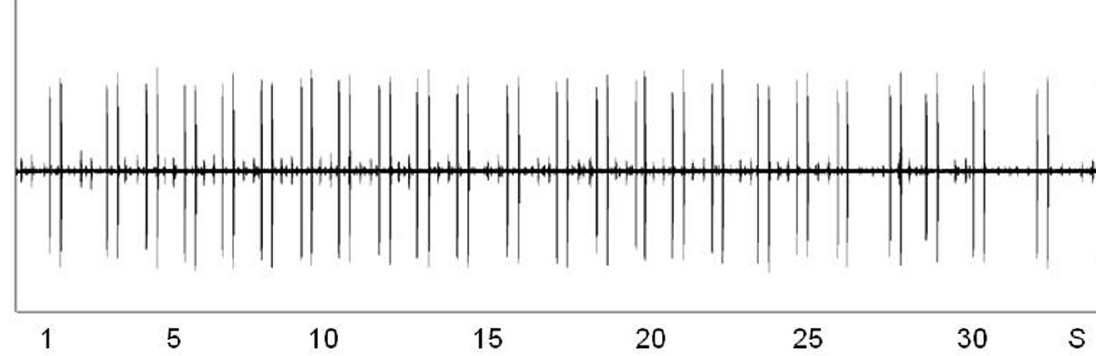
Figure 15. Wave form of a series of 25 calls from Choerophryne bisyllaba sp. n.